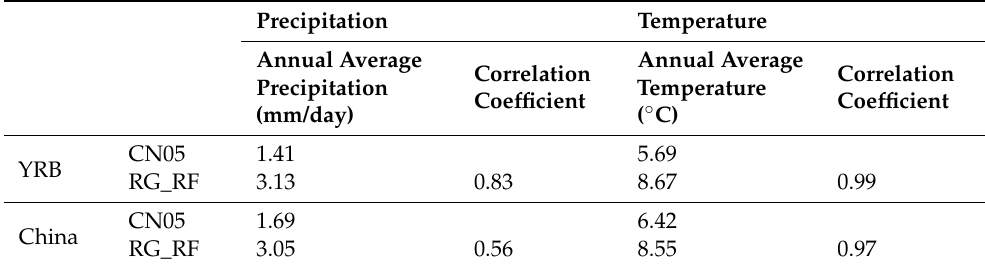
Table 3. Performance parameters of the RegCM4 for precipitation and air temperature in China and the